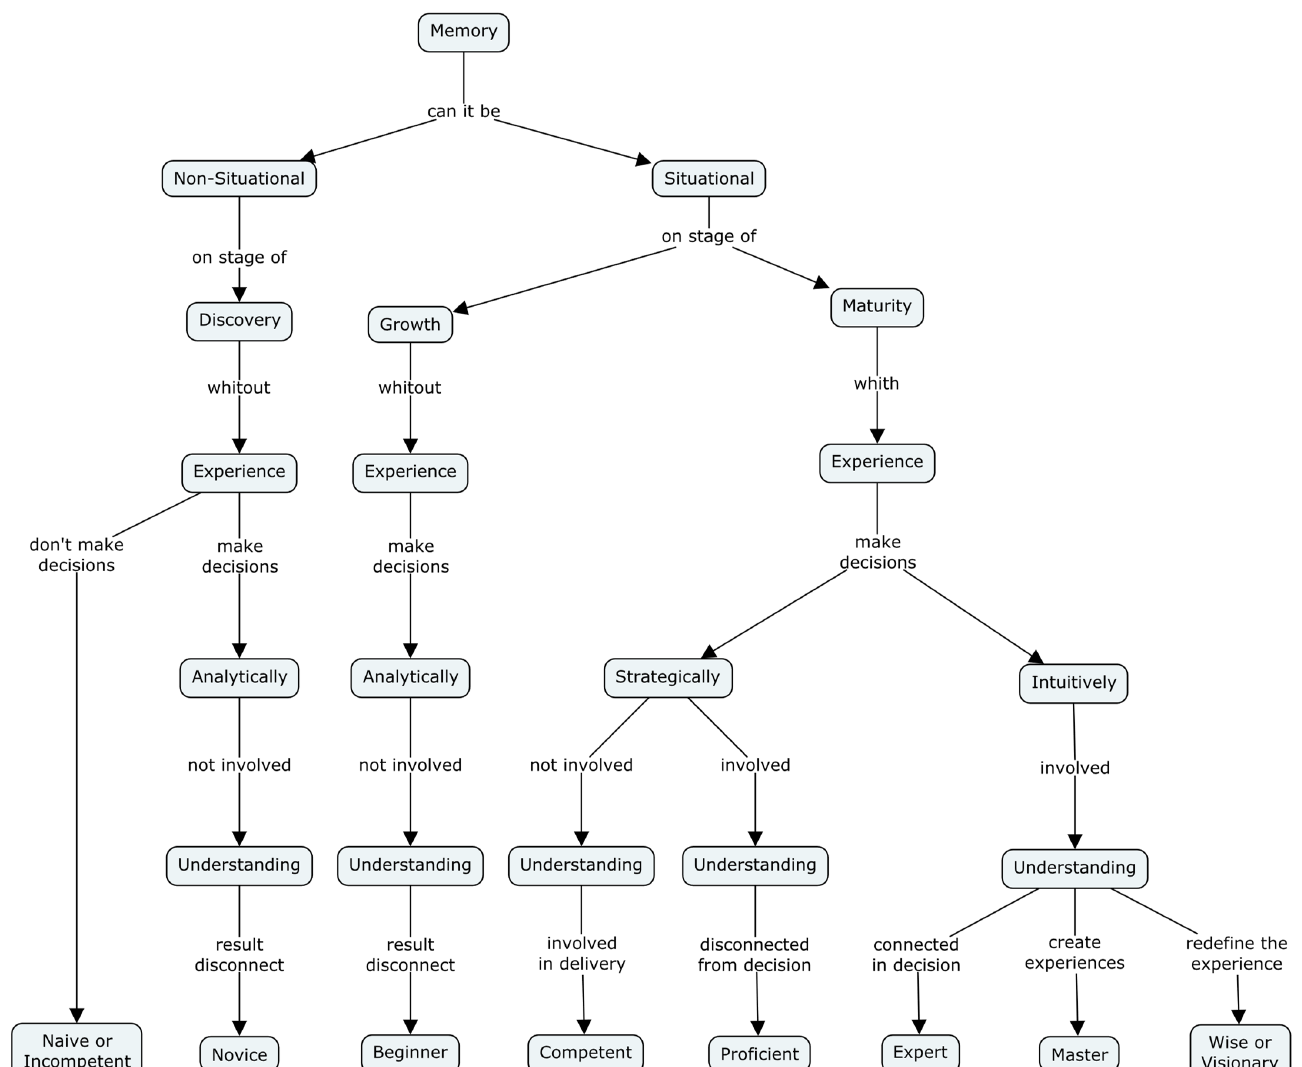
Figure 4. Cognitive map of classification of competence degrees.